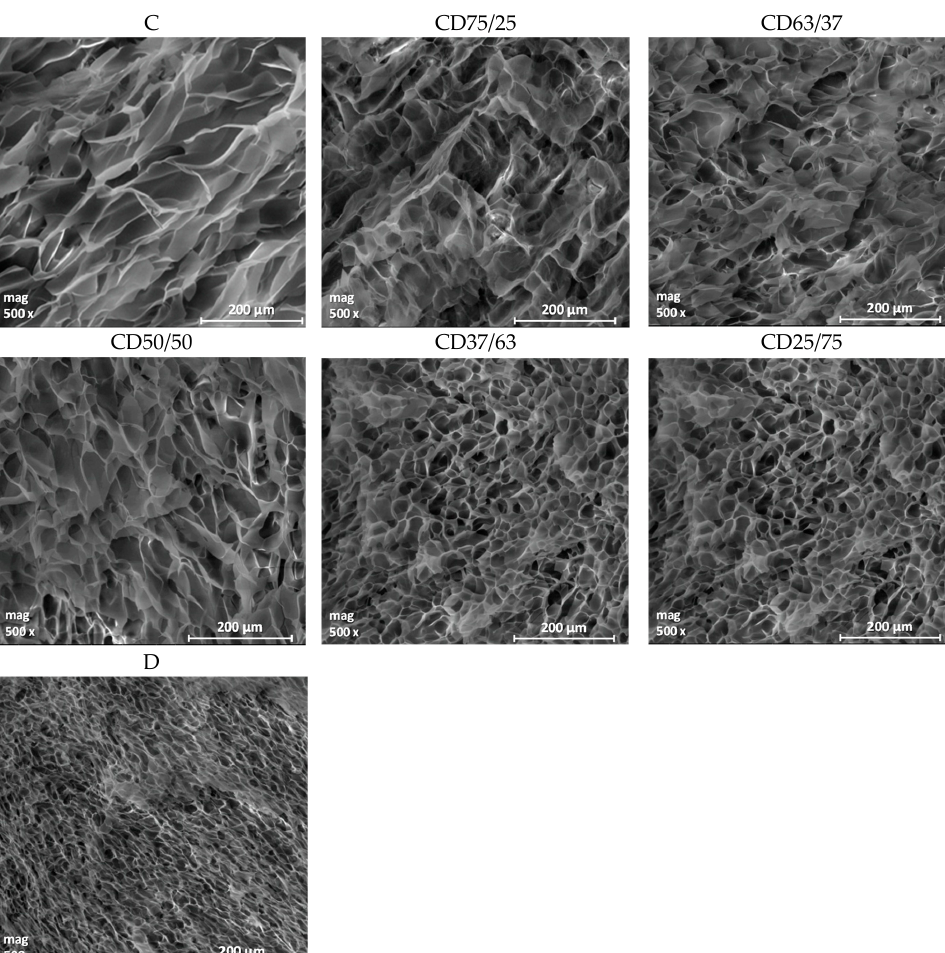
Figure 3. SEM images of the hydrogels obtained from cellulose (C), dextran (D) and their binary mixtures, in different gravimetric ratios (CD). mixtures, in different gravimetric ratios